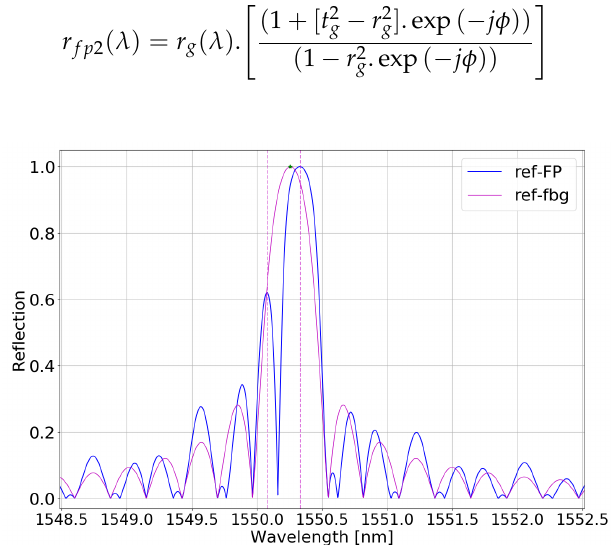
Figure 3. Normalized reflection spectrum of the FP